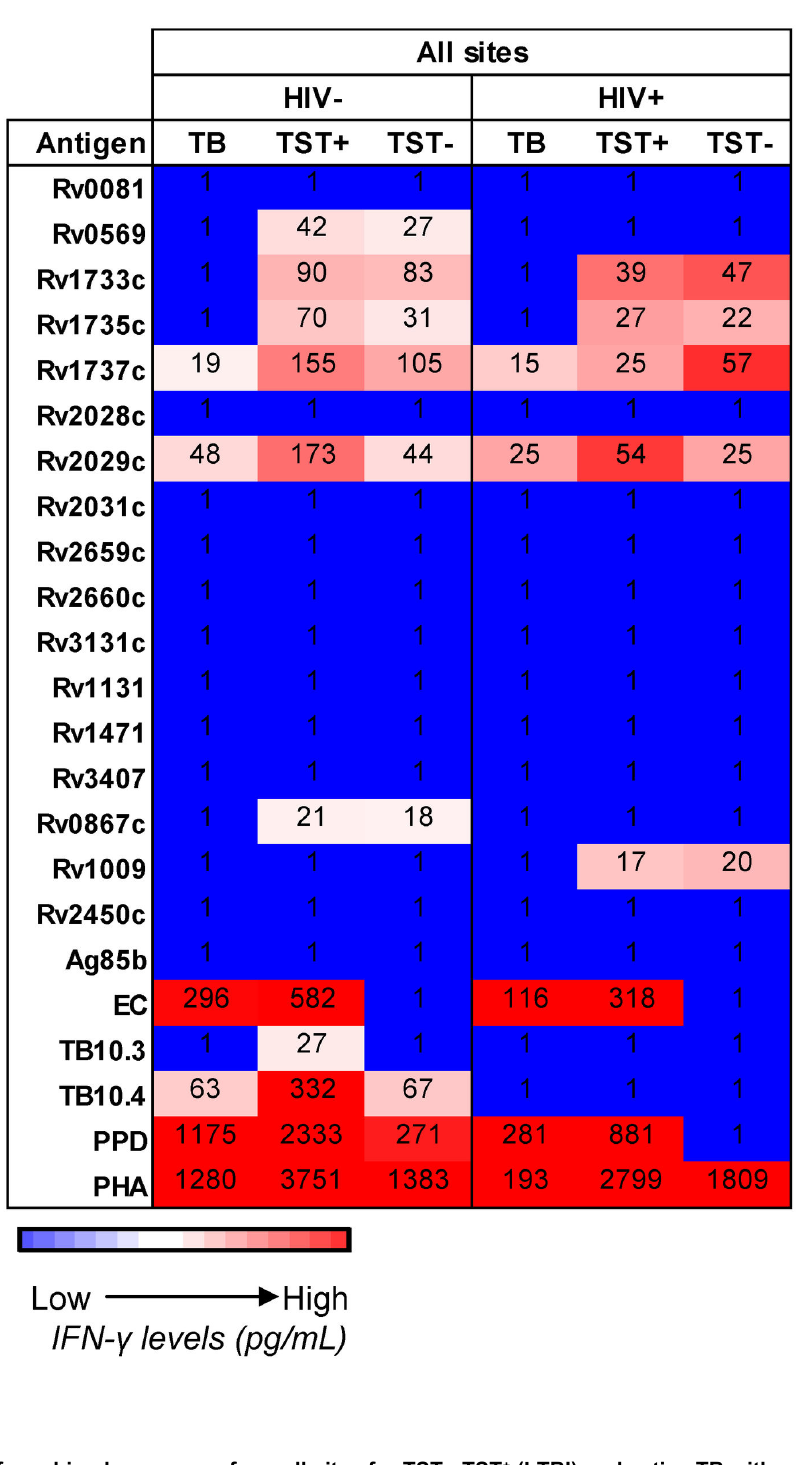
Figure 8. Heat map of combined responses from all sites for TST – , TST + (LTBI) and active TB with or without HIV infection in response to secreted, latent, and reactivation Mtb antigens. . Median levels of IFN-γ are shown (pg/mL). Red indicates relatively high levels of IFN-γ and blue indicates relatively low levels. HIV + = human immunodeficiency virus positive; HIV - = human immunodeficiency virus-negative; TB = active tuberculosis; LTBI = latently TB infected; SUN = Stellenbosch University, South Africa; MRC = Medical Research Council, The Gambia; AHRI = Armauer Hansen Research Institute, Ethiopia; KPS = Karonga Prevention Study, Malawi; MAK = Makerere University, Uganda. doi: 10.1371/journal.pone.0074080.g008 PLOS ONE |